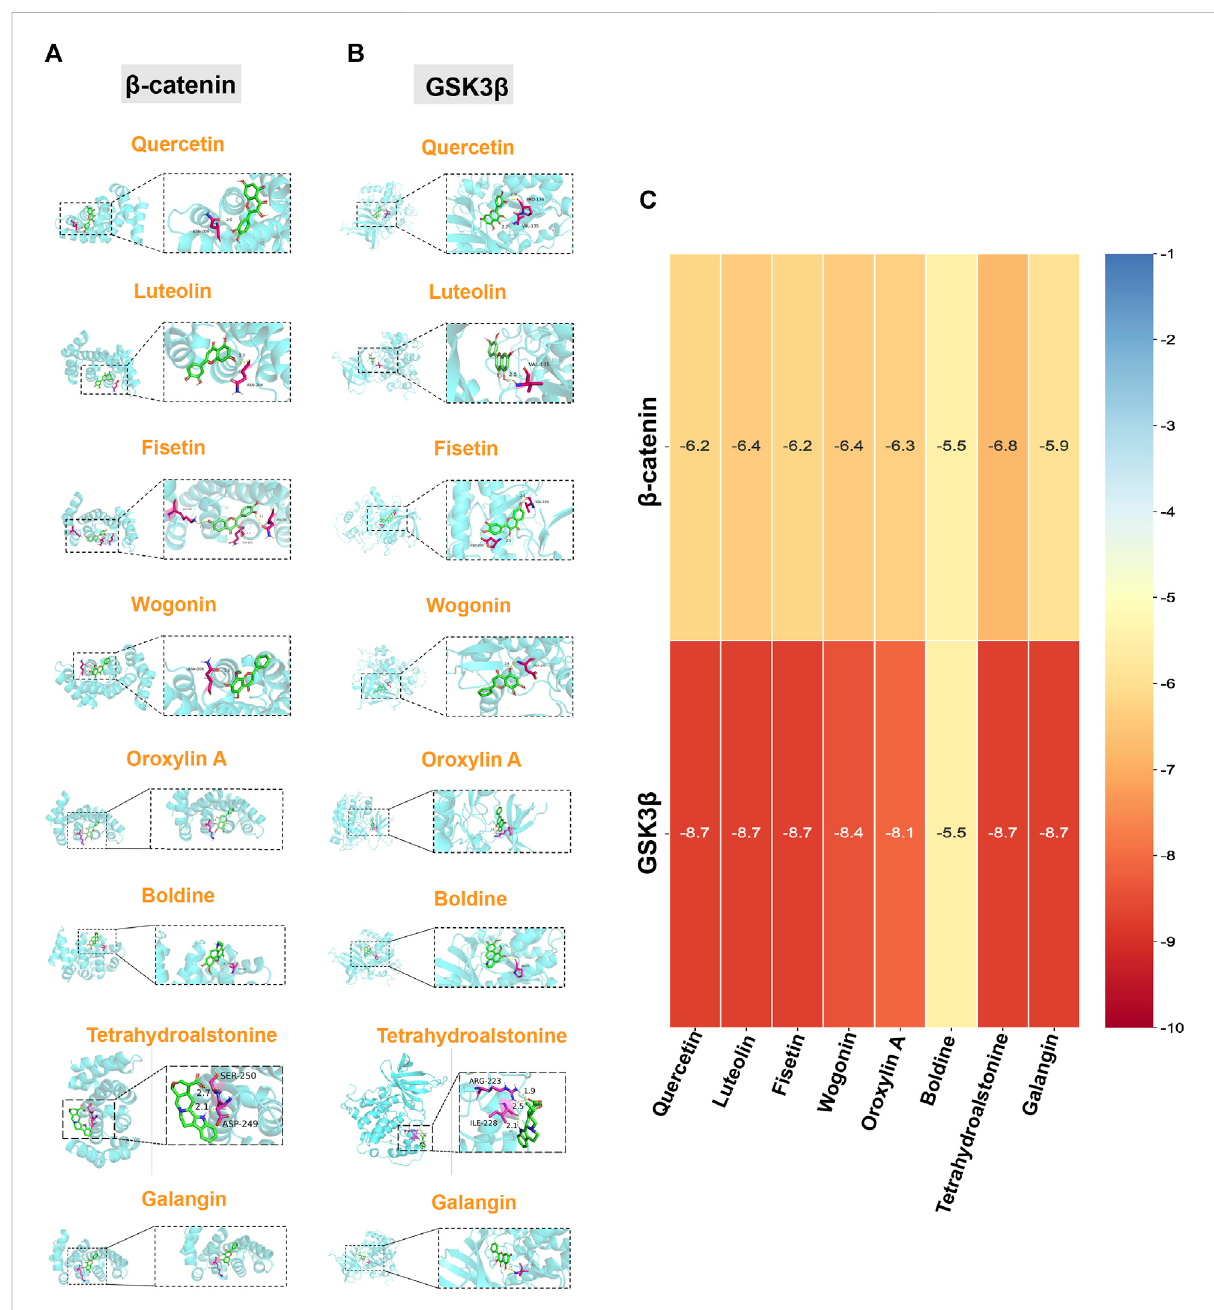
FIGURE 6 Molecular docking of core components and Wnt/ β -catenin-related targets. Quercetin, luteolin, fi setin, wogonin, oroxylin A, boldine, tetrahydroalstonine, and galangin with (A) β -catenin, and (B) GSK3 β . (C) Cluster heatmap of docking results. Numerical value indicated the binding energy